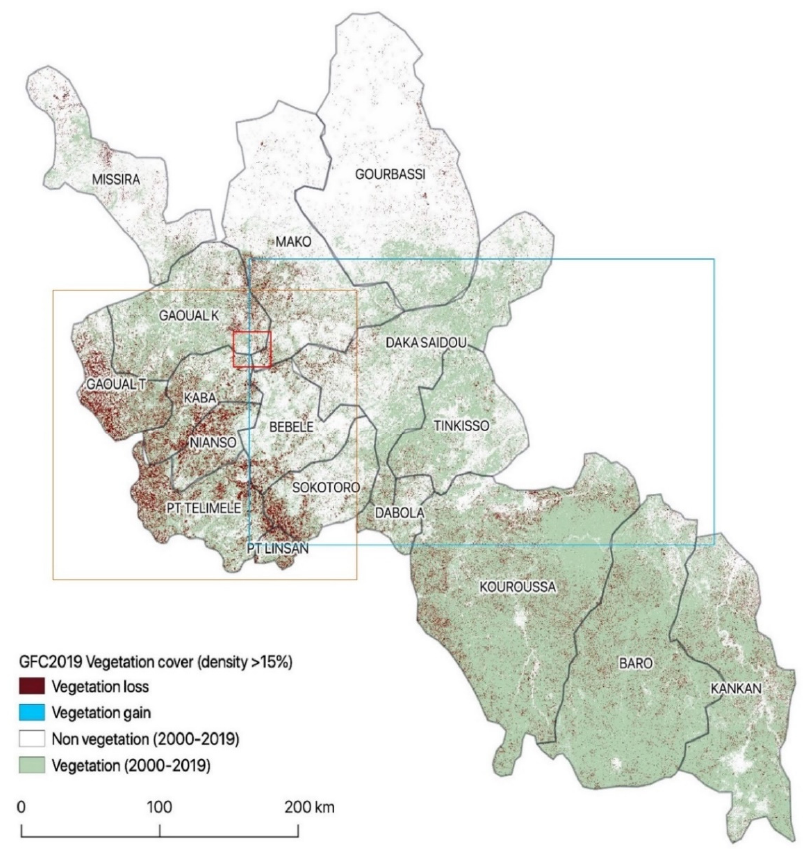
Figure 7. Vegetation (forest density higher than 15%) in 2000 and 2019 and vegetation loss and gain (GFC (Global Forest Change) product [29]), for the 16 basins. The empty brown rectangle is the area covered by the map in Figure 8.